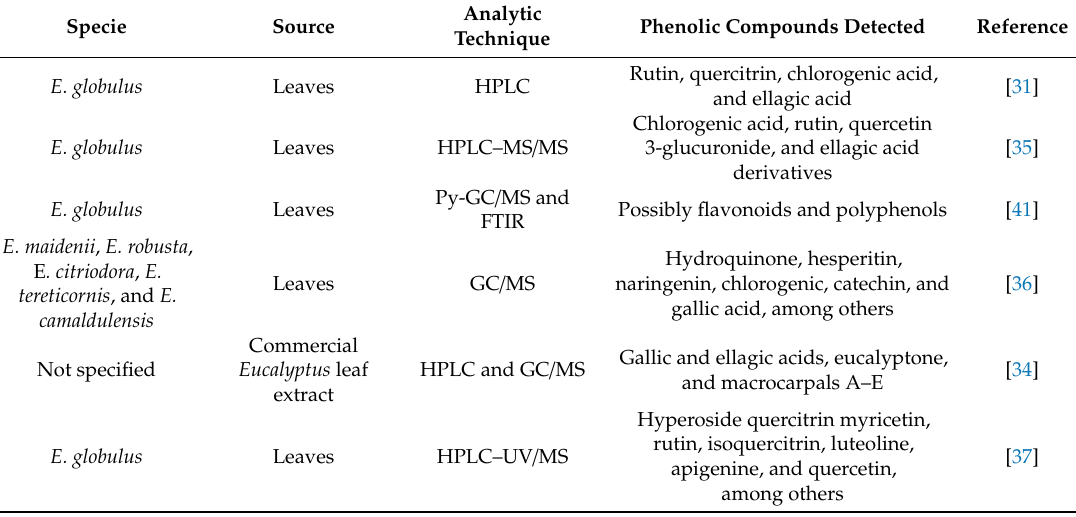
Table 1. Phenoliccompoundcharacterizationusinganalyticaltechniquesreportedfor Eucalyptus